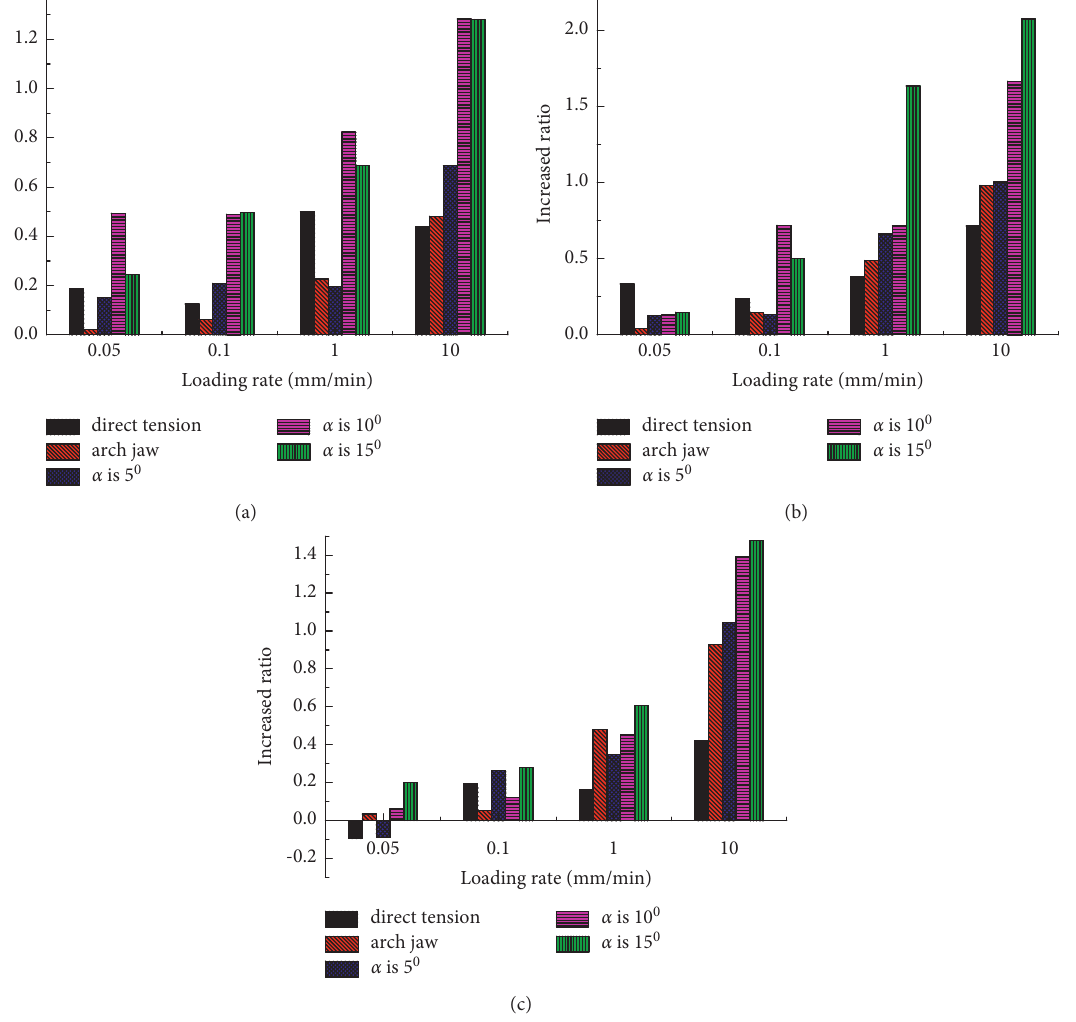
Figure 8: Increase ratios for the increasing loading rates: (a–c) increase ratios for the sandstone, rust stone, and granite stone specimens,